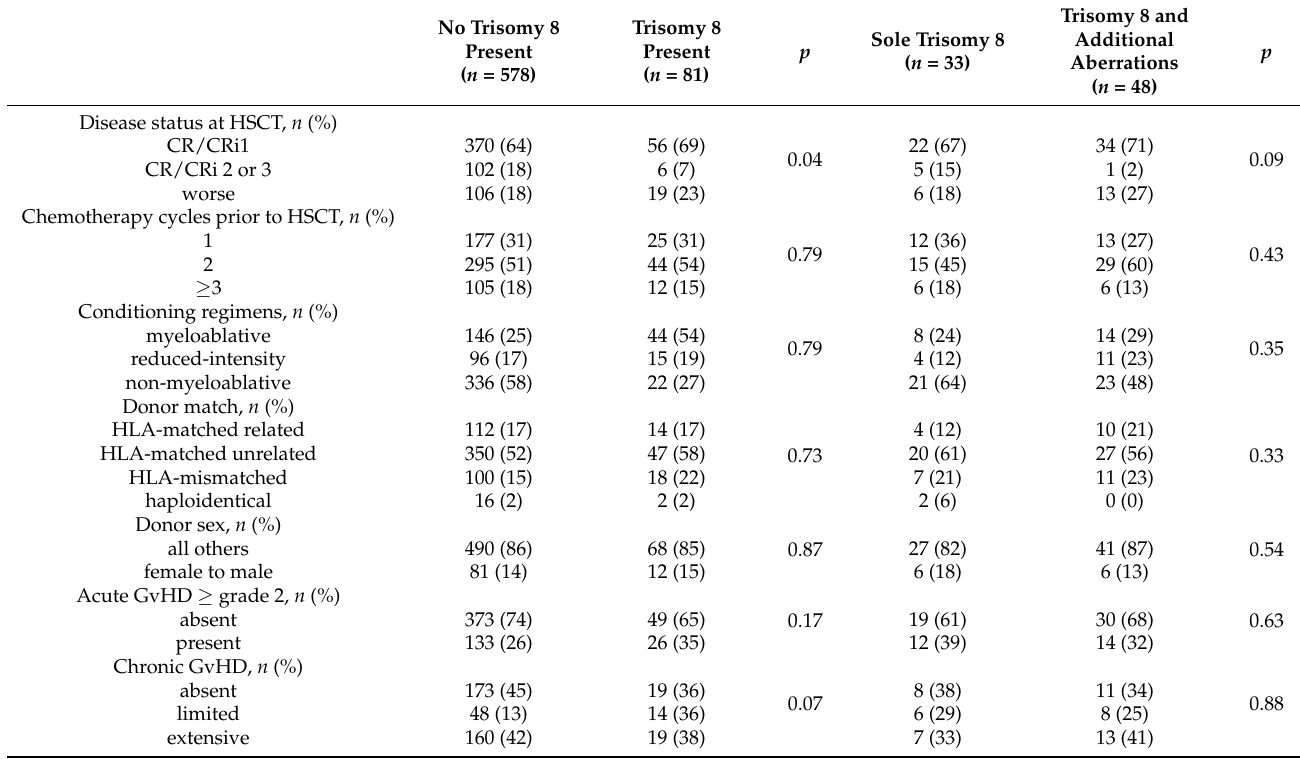
Table 2. HSCT-related characteristics of AML patients undergoing allogeneic HSCT according to the presence or absence of a trisomy 8 with or without additional cytogenetic aberrations ( n =